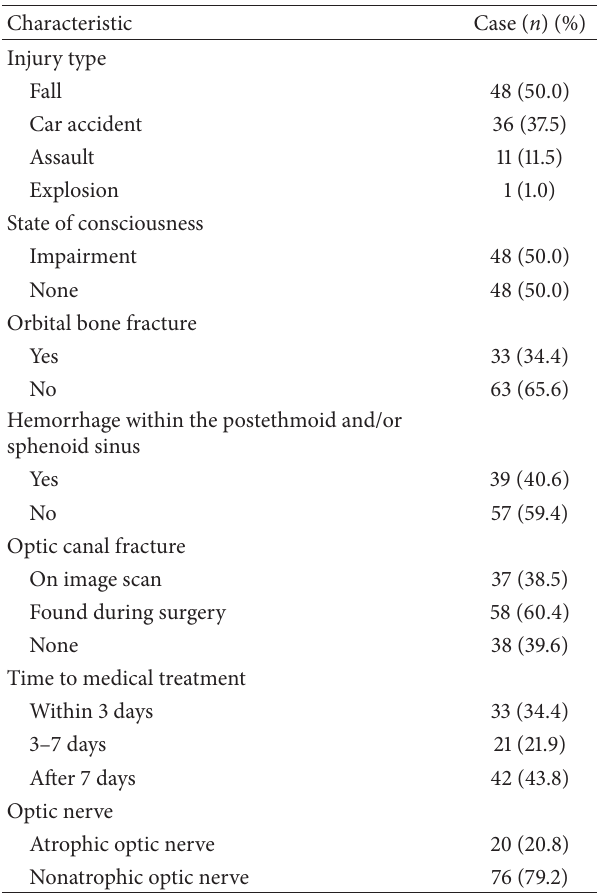
Table 1: Clinical characteristic of 96 NLP patients with ITON.